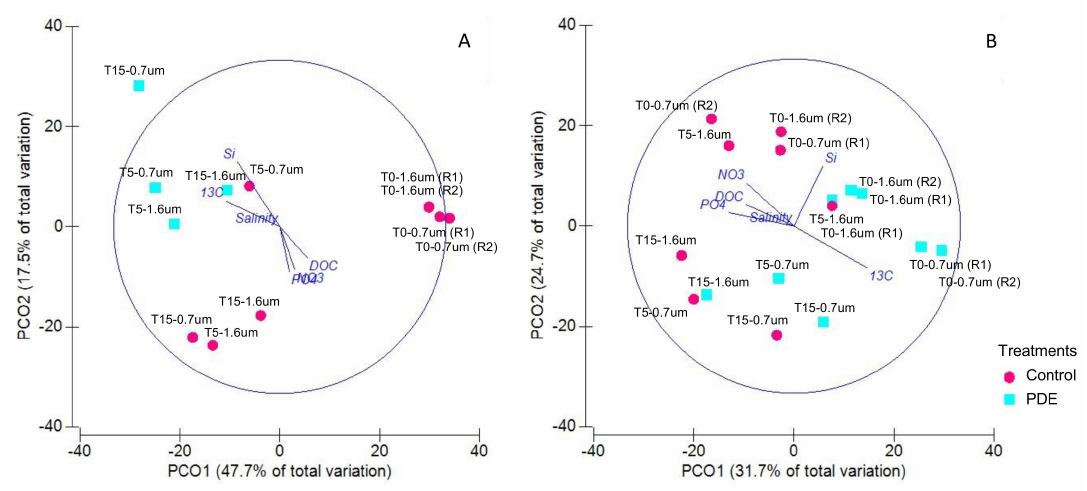
Figure 8. Principal component ordination of treatments with PDE and control based on Bray–Curtis similarity at order taxonomic level. ( A ) marine station 5 and ( B ) estuarine station 14. Vectors indicate the best environmental variables (normalized transformed) correlated with ordinations and vector lengths correspond to the correlation